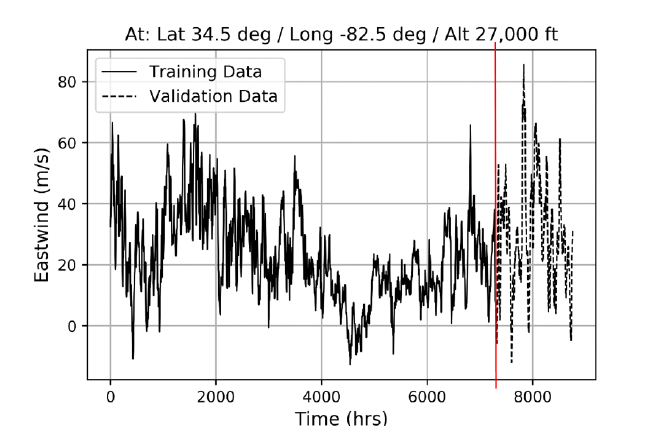
Figure 3. Decomposition of the MERRA-2 annual (2018) wind data into training (January–October) and validation (November–December)